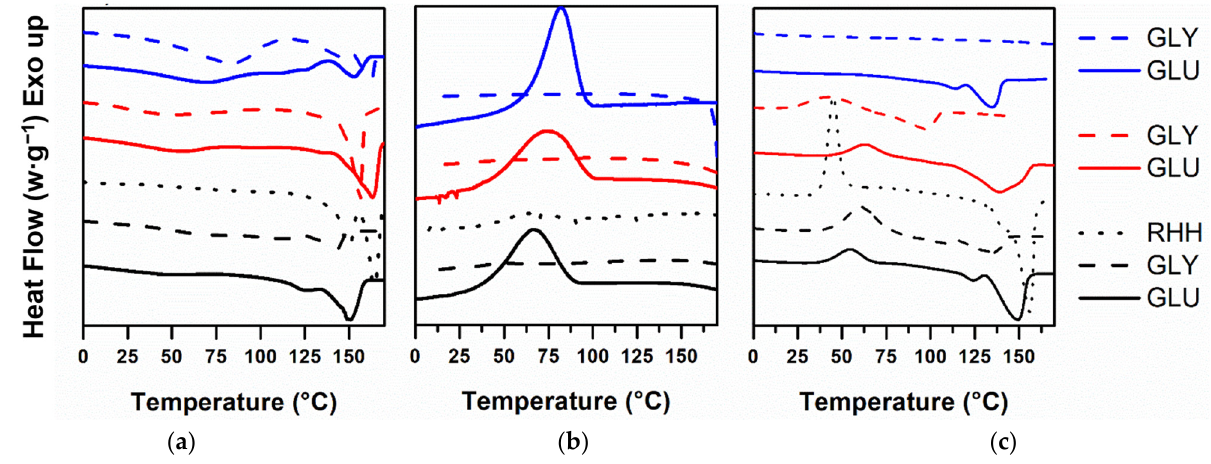
Figure 3. DSC ( a ) first heating ( b ) cooling and ( c ) second heating scans for the PHA produced with glucose (GLU), crude glycerol (GLY) and rice hull hydrolysate (RHH) and extracted with chloroform (black), sodium hypochlorite (red) and with chloroform and sodium hypochlorite (blue). Table 3. Physical characteristics of PHA obtained by extraction with different solvents.